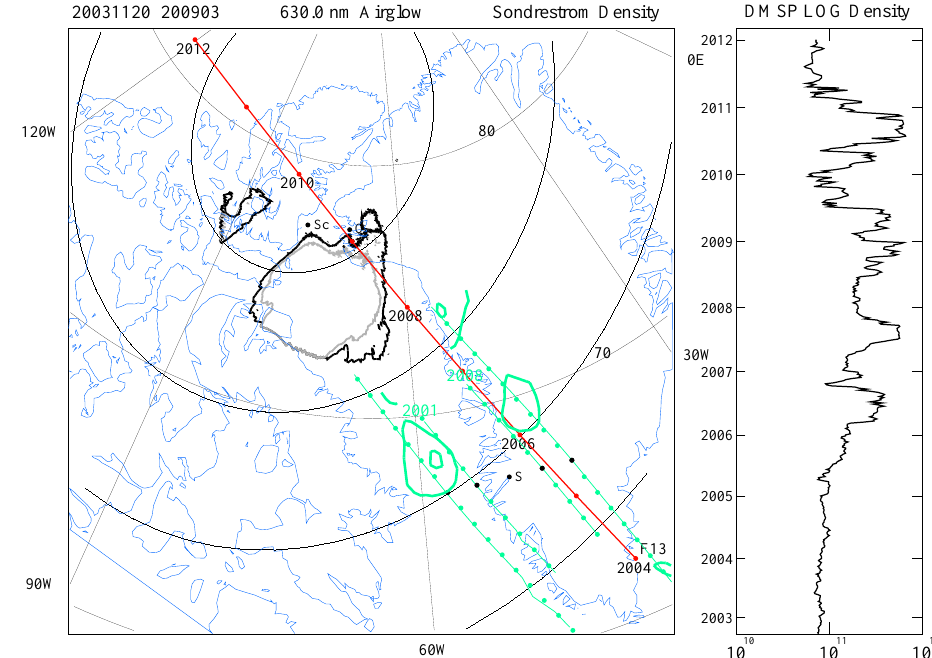
Figure 5. 630.0nm airglow emissions (black and gray contours) from Qaanaaq, Greenland, observed at 20:09UT on 20 November 2003 projected to 250km altitude. The trajectory of the DMSP-F13 pass is plotted in red. The red dots indicate the minute at which the satellite passed near Qaanaaq. The density measure by F13 is shown in the right panel. Densities measured by the Sondrestrom radar during two consecutive composite scans are indicated in